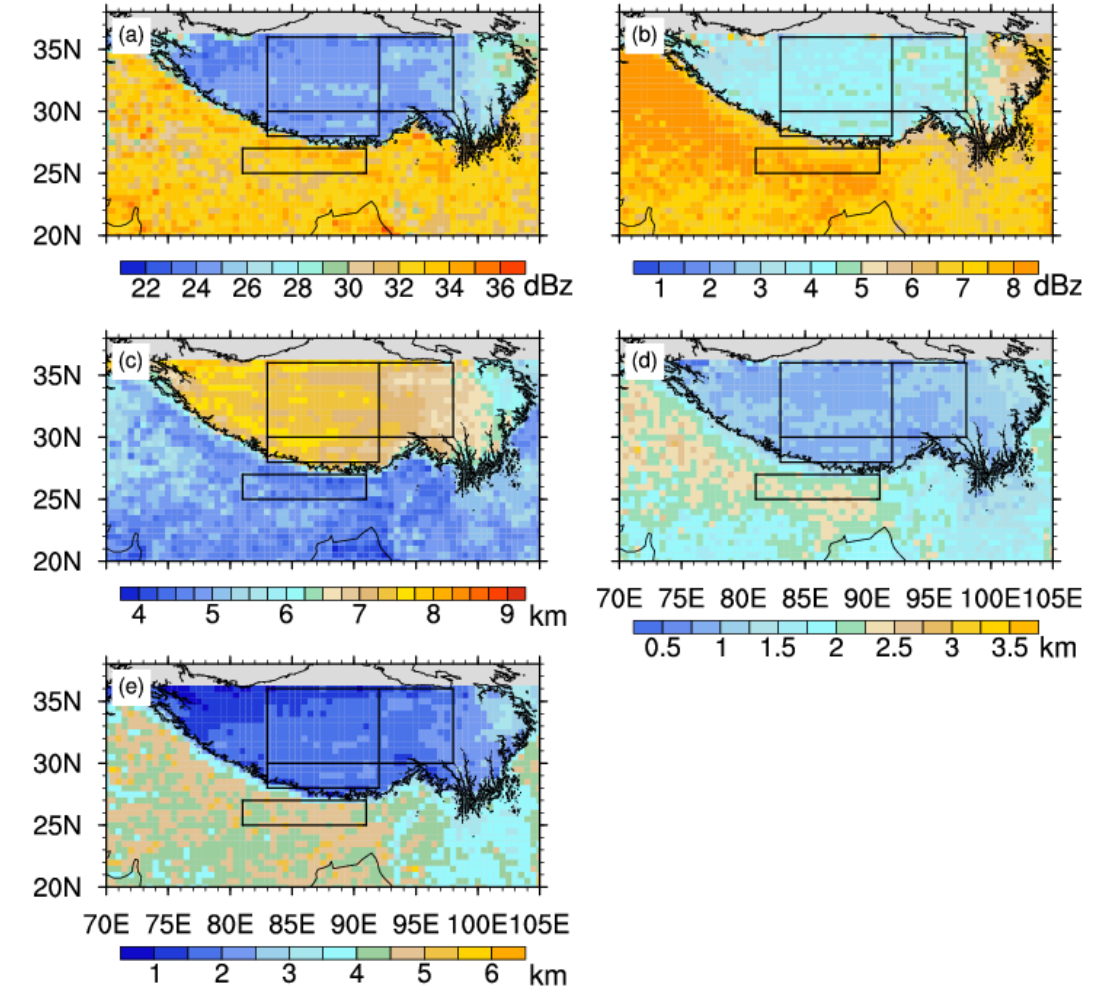
Figure 4. The distribution of ( a ) mean maximum echo and its ( b ) standard deviation, ( c ) mean altitude of the maximum echo and its ( d ) standard deviation, and ( e ) the height difference between the altitude of the echo top and the altitude of the maximum echo for DCP in summer over the QTP and its southern regions calculated from observations of TRMM PR from 1998 to 2012. The black boxes marked in each panel are seen in Figure 1.